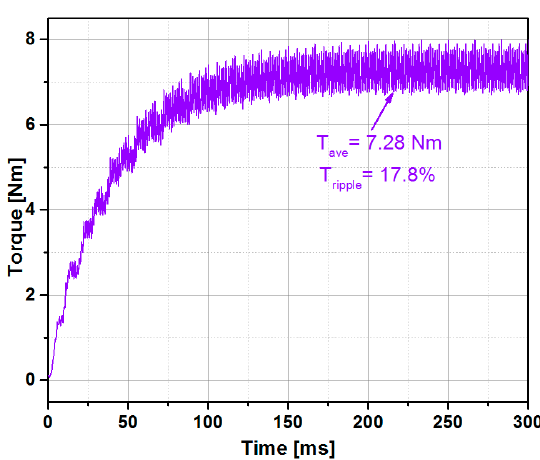
Figure 12. Field current (optimal model).